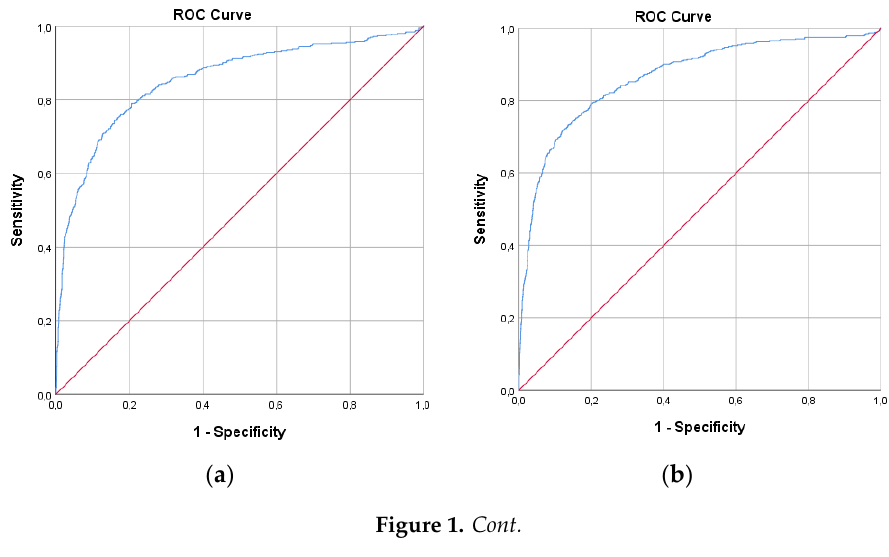
Table 6. Prediction accuracy of models measured by AUC.